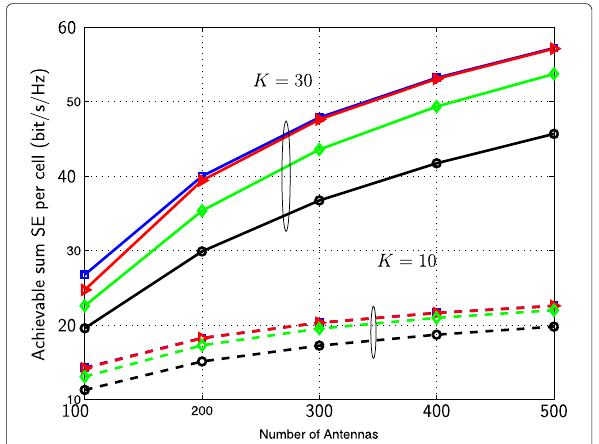
Fig. 3 Achievable sum SE of M-MMSE ( squares ), M-ZF ( triangles ), S-MMSE ( diamonds ), and MF ( circles ) with β =